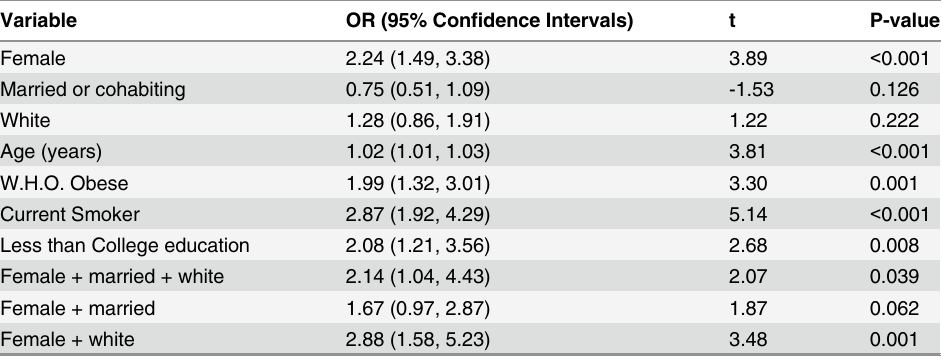
Table 7. Multivariable logistic regression of predictors of physician diagnosis of fibromyalgia: Model predicting persons meeting 2012 NHIS fibromyalgia criteria (excluding Polysymptomatic Distress